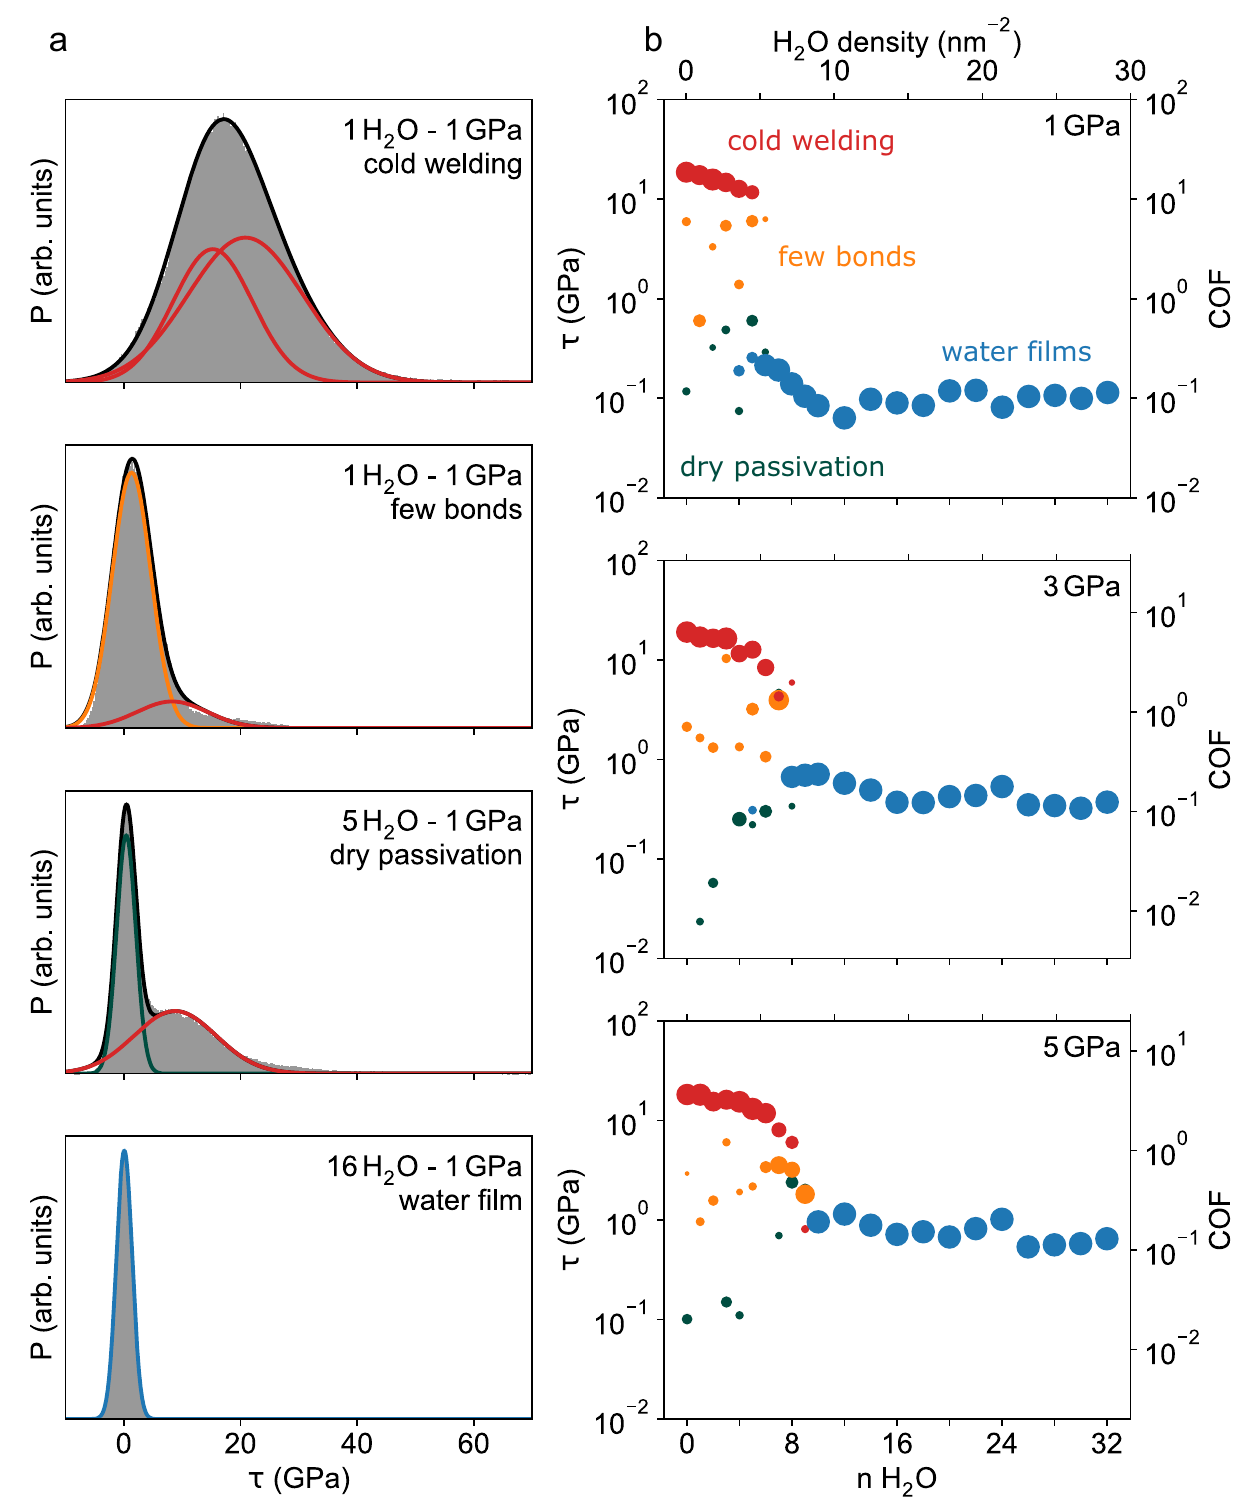
Fig.10|Typicalshearstressesinthedifferentregimes.a Probabilitydensities(P) fortheshearstress τ forthetypicalsystemevolutionatanormalpressureof 1GPa. Coloredlinesshow χ 2 - fi ts of gaussians to the probability densities. b Average shear stresses determined from the Gaussian fi ts to the densities as a function of the